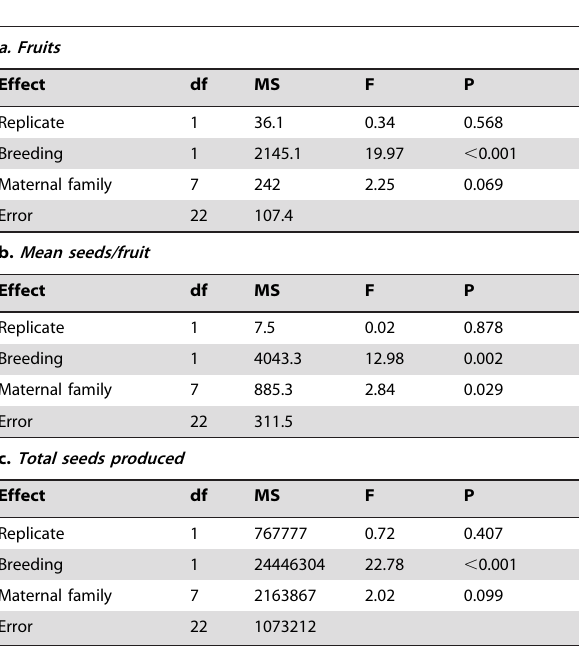
Table 1. Variance analysis for reproductive output in year